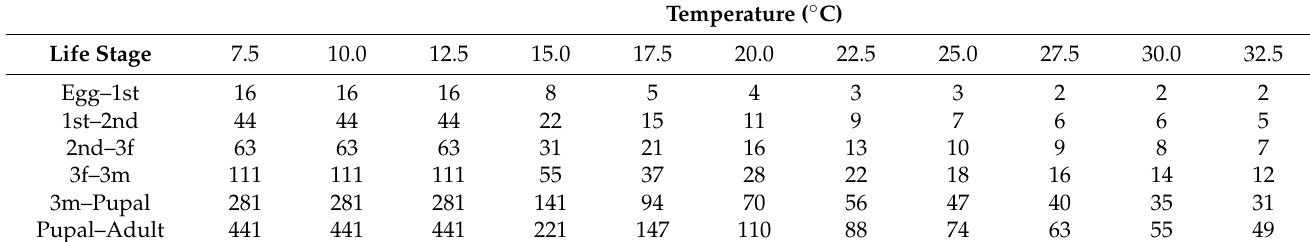
Table 2. Sample times for Phormia regina were calculated by converting the minimum and maximum data reported in Kamal [4] into accumulated degree hours (ADH). The ADHs were calculated for each life stage and sampling temperature, converted back into hours and divided into 5 equal sample